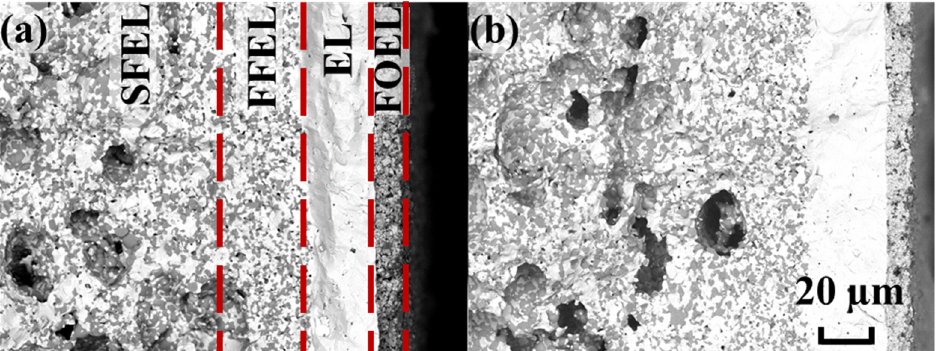
Figure 8. Cross-sectional view of the fabricated PCFC using BCZYF0.6 electrode before ( a ) and after ( b ) electroactivation.